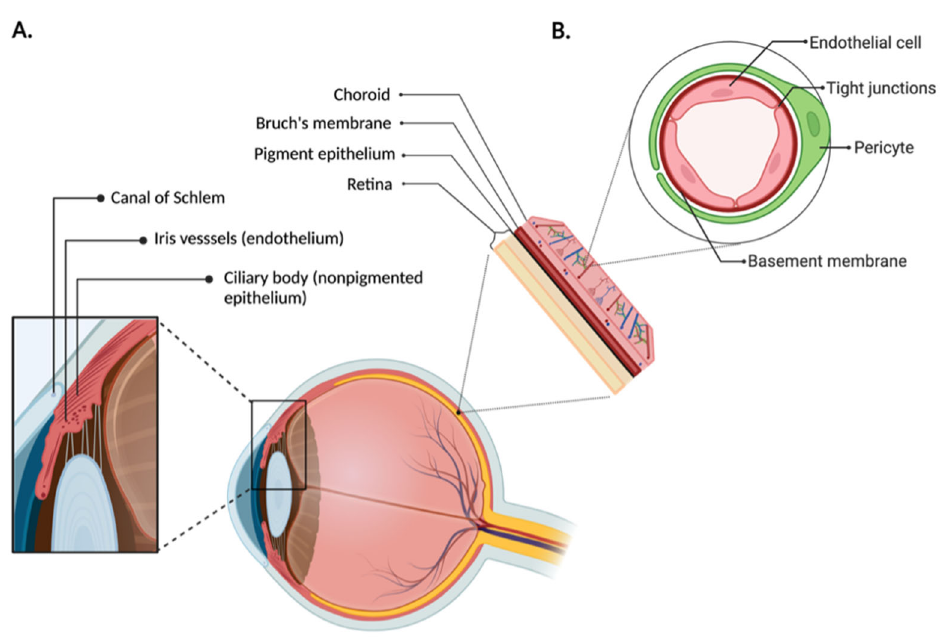
Figure 1. Anatomical barriers of the eye. ( A ) In the anterior of the eye, the blood–aqueous barrier, consisting of the iris/ciliary blood vessels and nonpigmented ciliary epithelium, limits access to the anterior of the eye and prevents therapeutic entry to the intraocular environment. ( B ) In the posterior of the eye, the blood-retinal barrier, comprised of the retinal capillary endothelial cells and retinal pigment epithelium cells, prevents therapeutics from entering the posterior segment from the bloodstream.